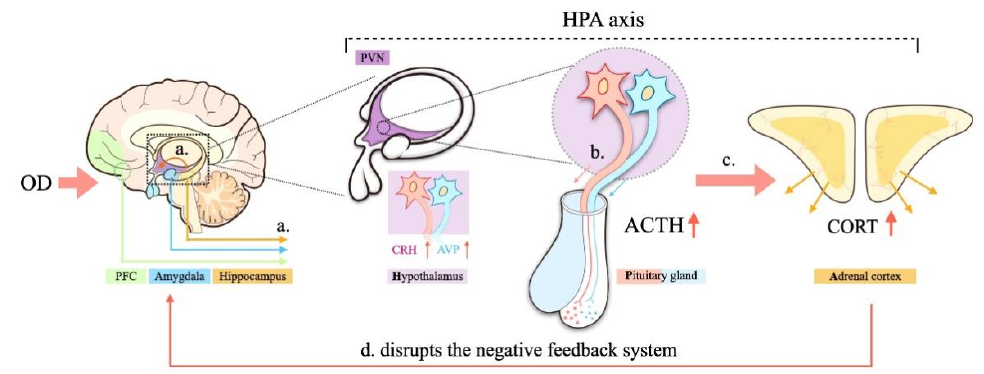
Figure 5 . Simplified diagram showing the relationship between OD and the HPA axis. ( a ) OD results in hypersecretion of hypothalamic CRH; ( b ) CRH promotes secretion of ACTH; ( c ) ACTH stimulates the synthesis and secretion of CORT; ( d ) hypersecretion of CORT disrupts the negative feedback system of the HPA axis.